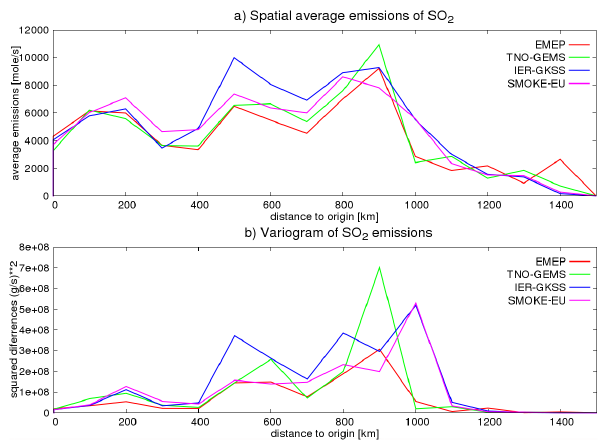
Fig. 8. (a) Spatial average annual SO 2 emissions of different emission datasets for the year 2000. (b) Variograms for SO 2 emissions of different emission datasets for the year 2000. All values are for concentric circles with a 100km distance on a 54 × 54km 2 domain (Fig.